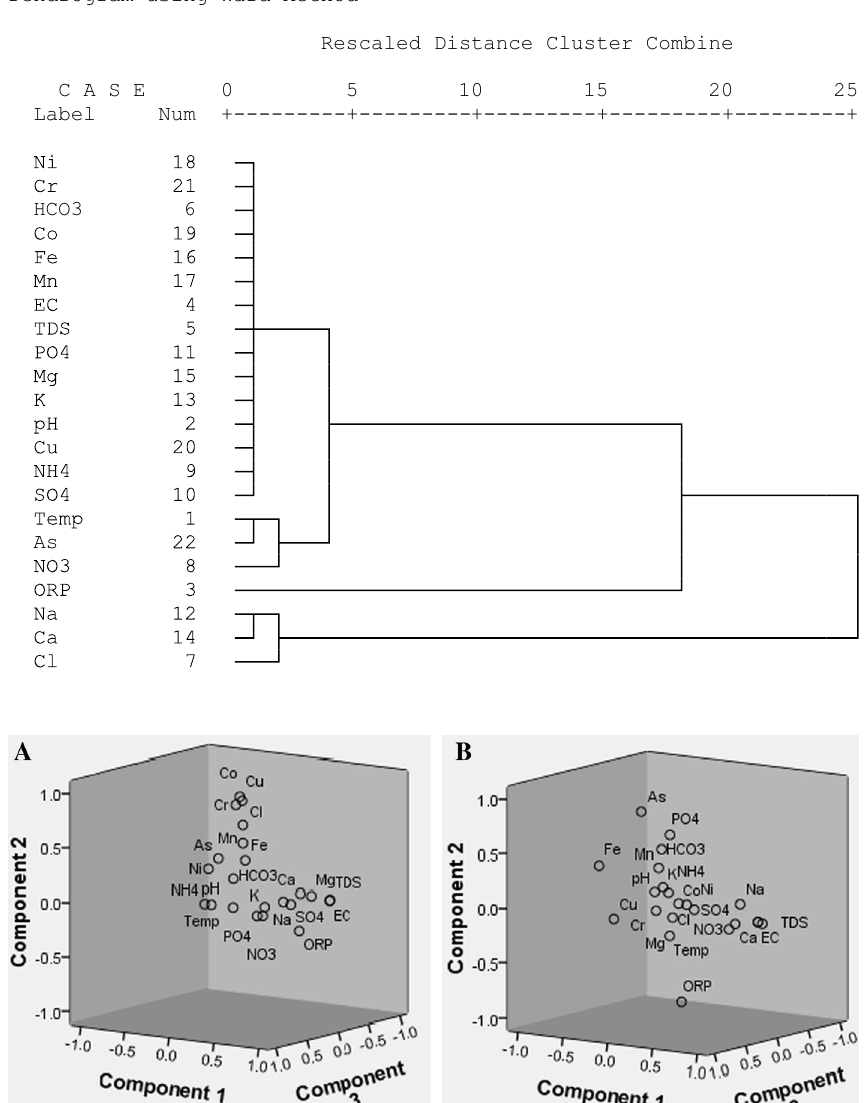
Fig. 4 Hierarchical dendrogram